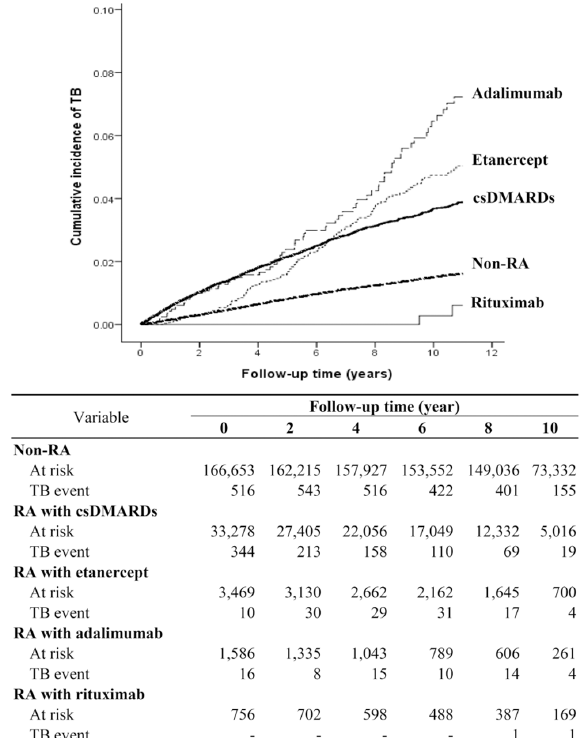
Fig 2. Cumulative incidence of tuberculosis in RA patients, who received therapy with csDMARDs, etanercept, adalimumab or rituximab, in comparison with non-RA subjects. csDMARDs: conventional synthetic disease-modifying anti-rheumatic